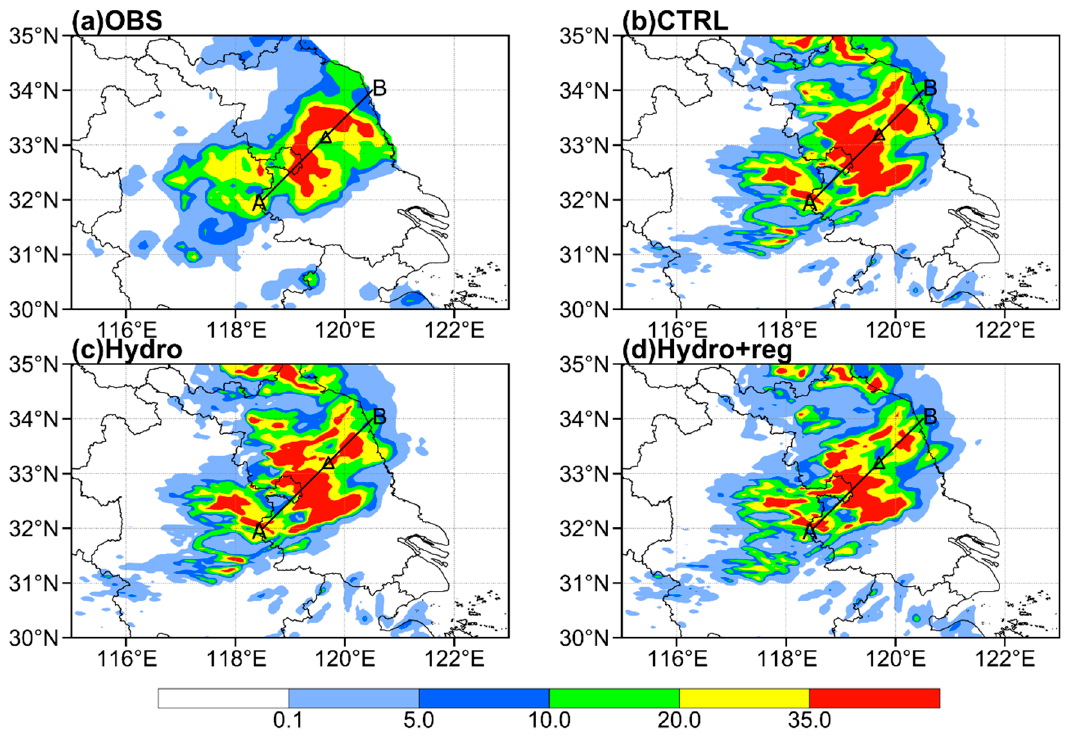
Figure 11. Distribution of 3-h accumulated precipitation forecast from 0800 UTC to 1100 UTC on 6 July 2019, in main precipitation area (units: mm), and the triangle is the position of (33.2 ° N, 119.7 ° E) where Skew-T plots will be analyzed: ( a ) Observation, ( b ) CTRL, ( c ) Hydro, ( d ) Hydro+reg. The Figure 13. Figure